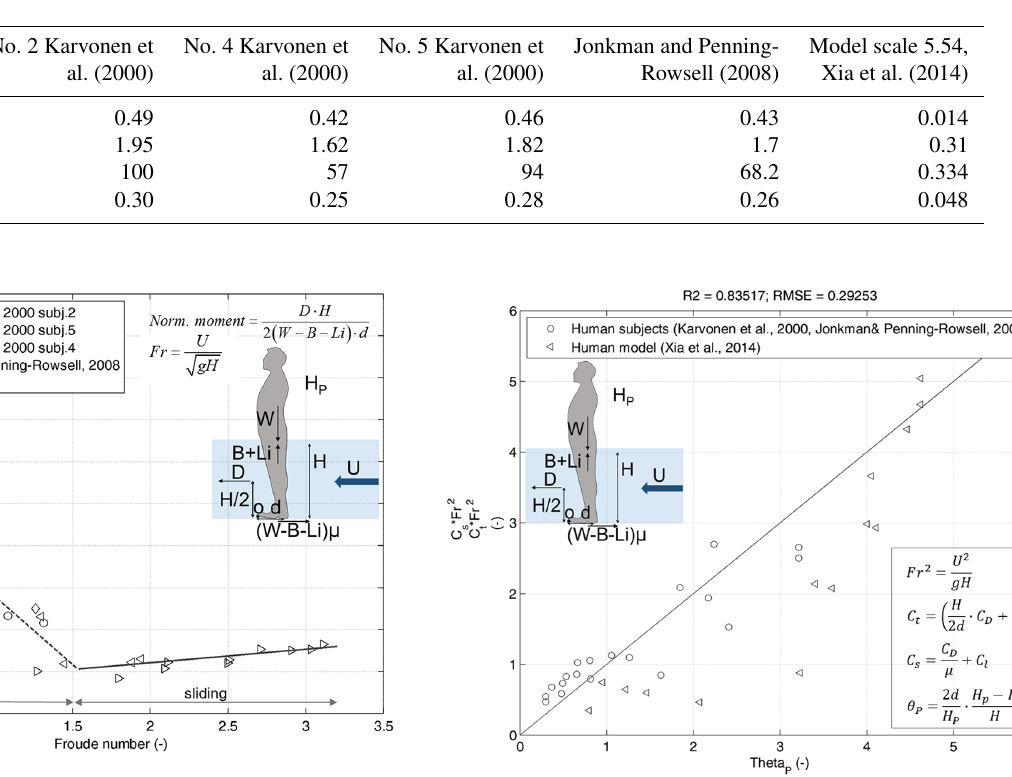
Table 3. Reference areas for force coefficients calculation and physical characteristics (height H P , weight W and length of the foot d ) of human subjects and human-scale model.